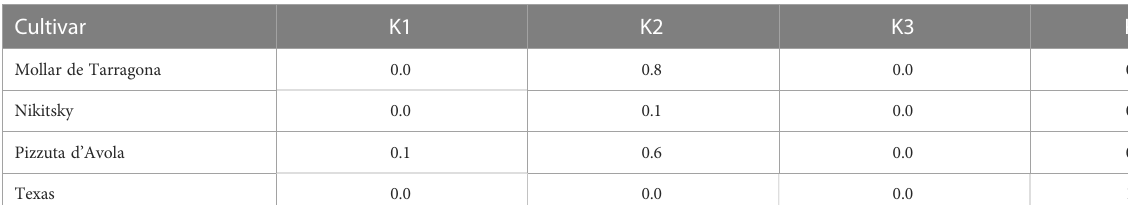
TABLE 2 ADMIXTURE membership coef fi cient for the four ancestral populations K1, K2, K3 and K4, relative to four cultivars ( “ Mollar de Tarragona ” , “ Nikisky ” , “ Texas ” and “ Pizzuta D ’ Avola ” ) carrying at least one copy of the Sk-2